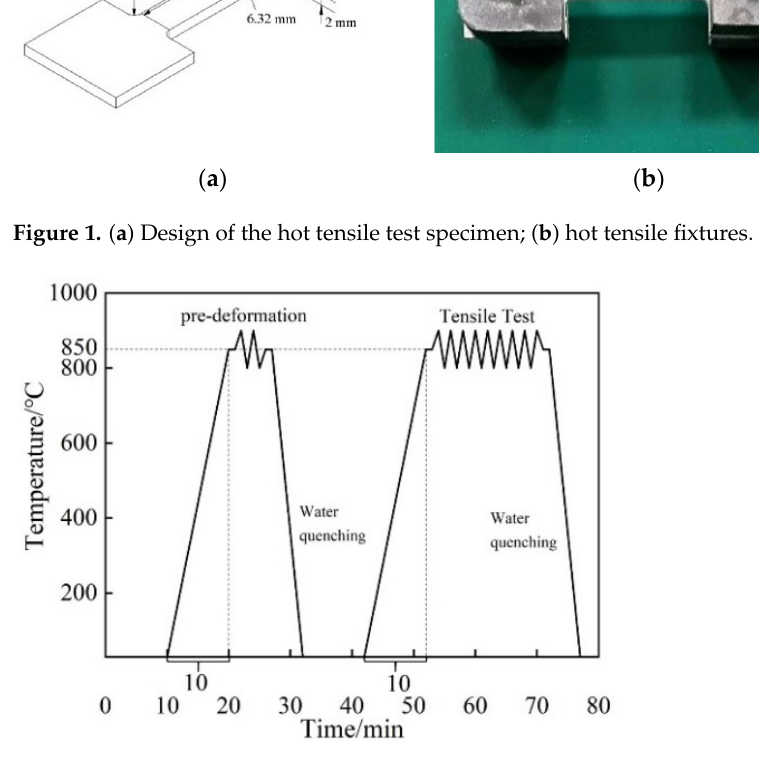
Figure 2. Schematic diagram of the Ti ‐ 6Al ‐ 4V hot tensile test heating